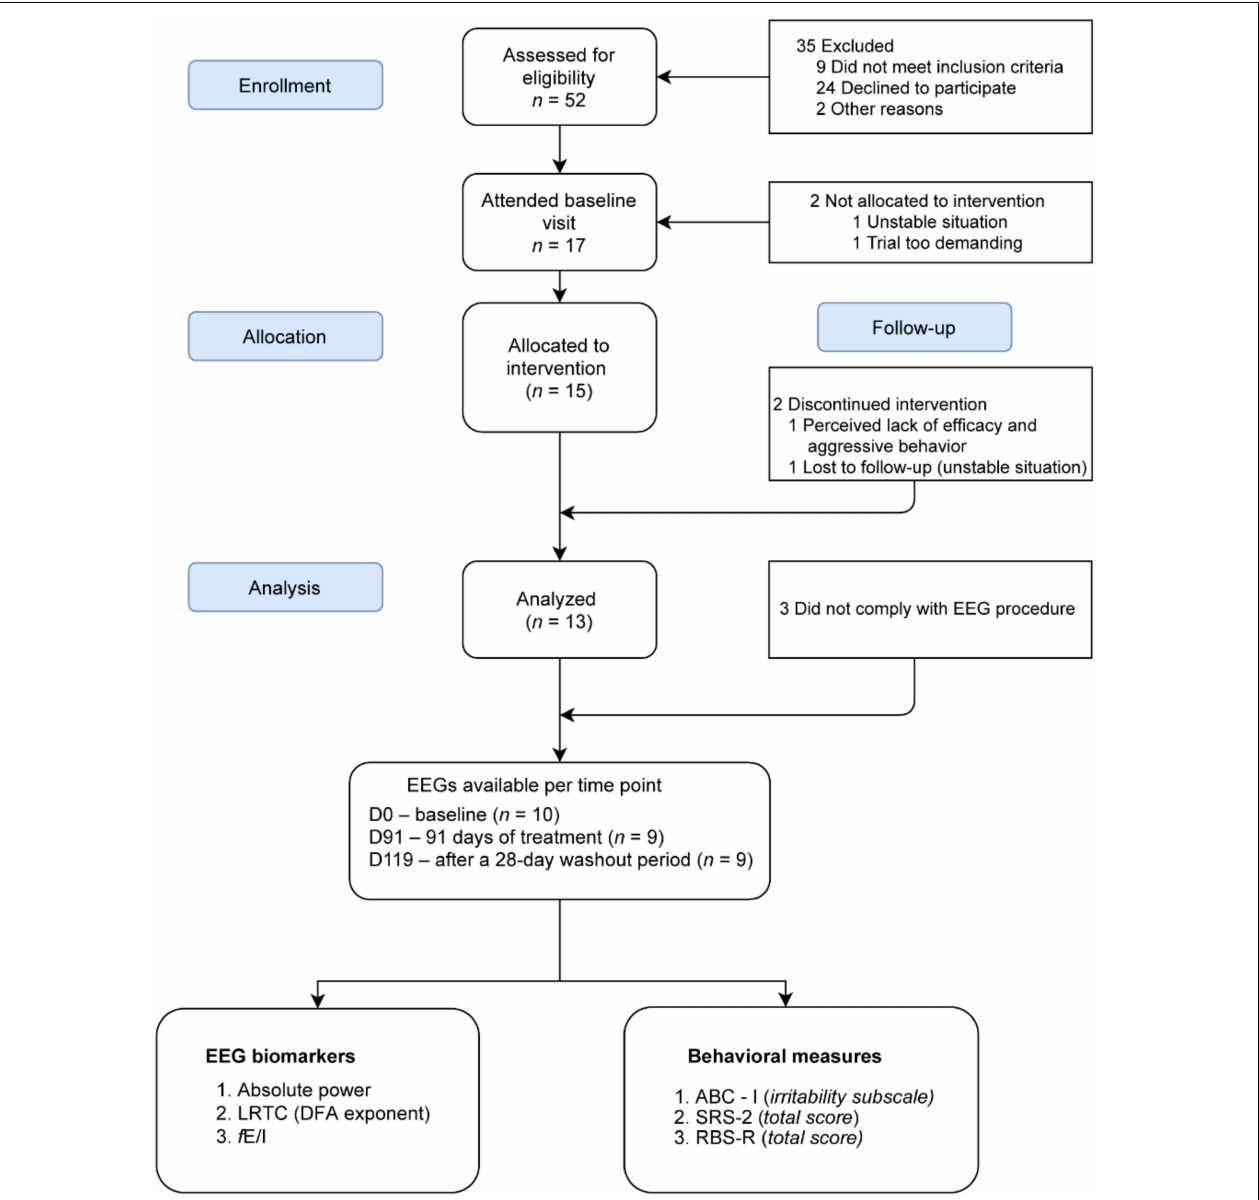
FIGURE 1 | CONSORT flow diagram for the patients included for EEG analysis from the BATSCH trial. A total of 52 subjects were screened for eligibility from March 2017 to April 2018 at the UMC Utrecht, Netherlands. 15 participants received bumetanide. EEG recordings of 10 participants were available for analysis. CONSORT, Consolidated Standards of Reporting Trials; BATSCH, Bumetanide to Ameliorate Tuberous Sclerosis Complex Hyperexcitable Behaviors trial; ABC-I, Aberrant Behavior Checklist-Irritability subscale; SRS-2, Social Responsiveness Scale-2; RBS-R, Repetitive Behavior Scale-Revised; LRTC, long-range temporal correlations; DFA, scaling exponent of the detrended fluctuation analysis; fE / I , excitation-inhibition